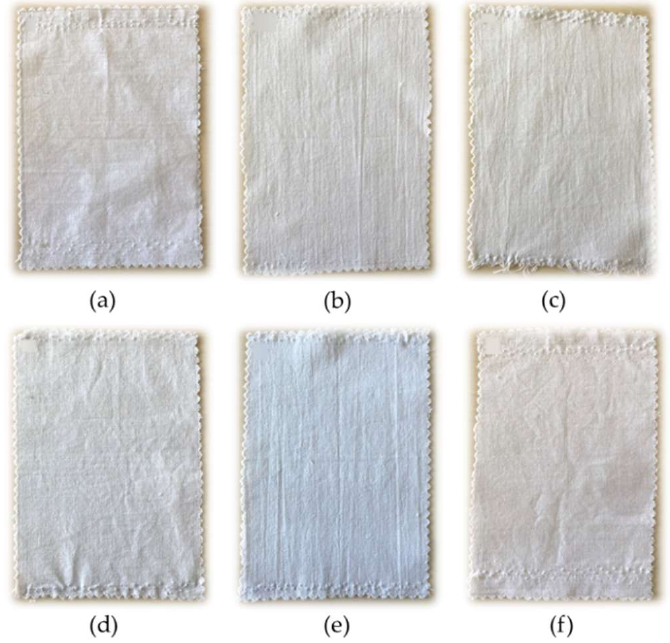
Figure 5. Cotton modified with sol–gel solution. ( a ) COT + G, ( b ) COT + G/C2_C′2, ( c ) COT + G/C8_C′8, ( d ) COT + G/C16_C′16, ( e ) COT + G/C2_C′16, and ( f ) COT +